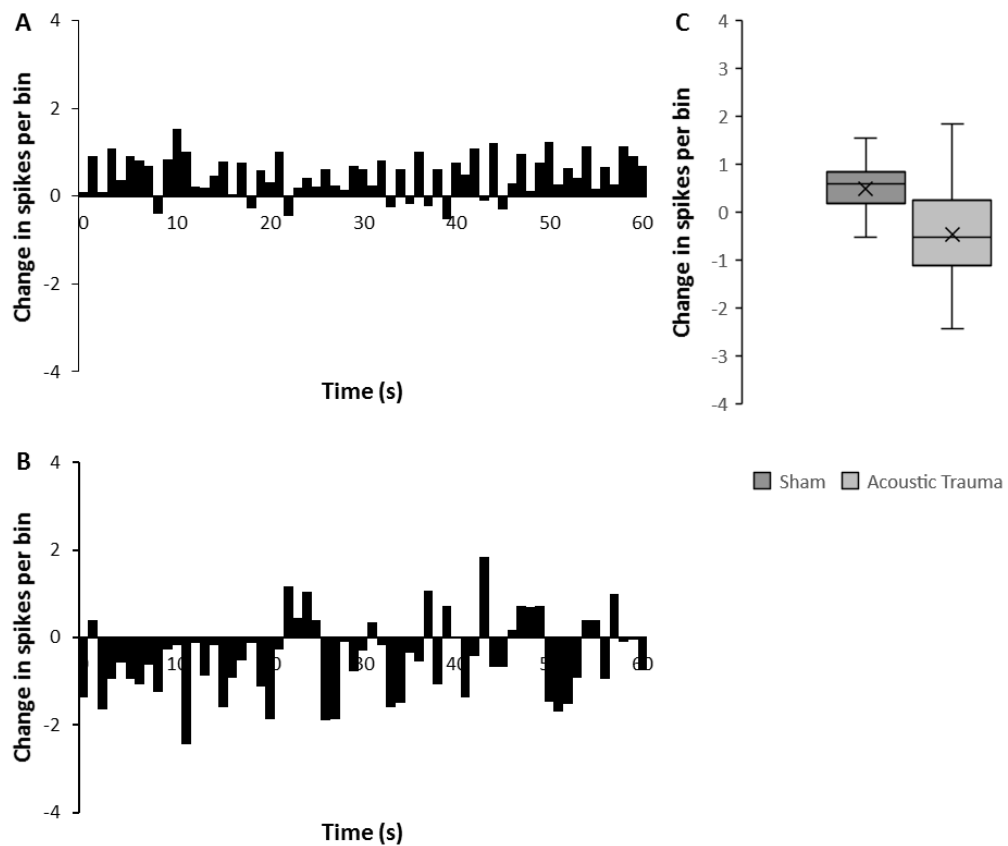
Figure 4. Changes in medial geniculate nucleus (MGN) firing after acoustic trauma (AT) and with prefrontal cortex (PFC) prolonged electrical stimulation. ( A , B ) Rate histograms showing mean change (spikes/bin over 60 s following 2 min of PFC electrical stimulation) in medial geniculate nucleus (MGN) firing rates, 2 weeks after sham ( A ) or acoustic trauma ( B ). ( C ) The average change of spikes per bin after PFC electrical stimulation in sham versus AT animals. The time point of 0 denotes the end of stimulus in ( A , B ). Table 1. Responses of individual medial geniculate nucleus neurons that were assessed using both brief repetitive and prolonged electrical stimulation of the PFC in sham and AT animals, showing the variability of responses to either type of electrical stimulation within neurons. Shown are absolute numbers